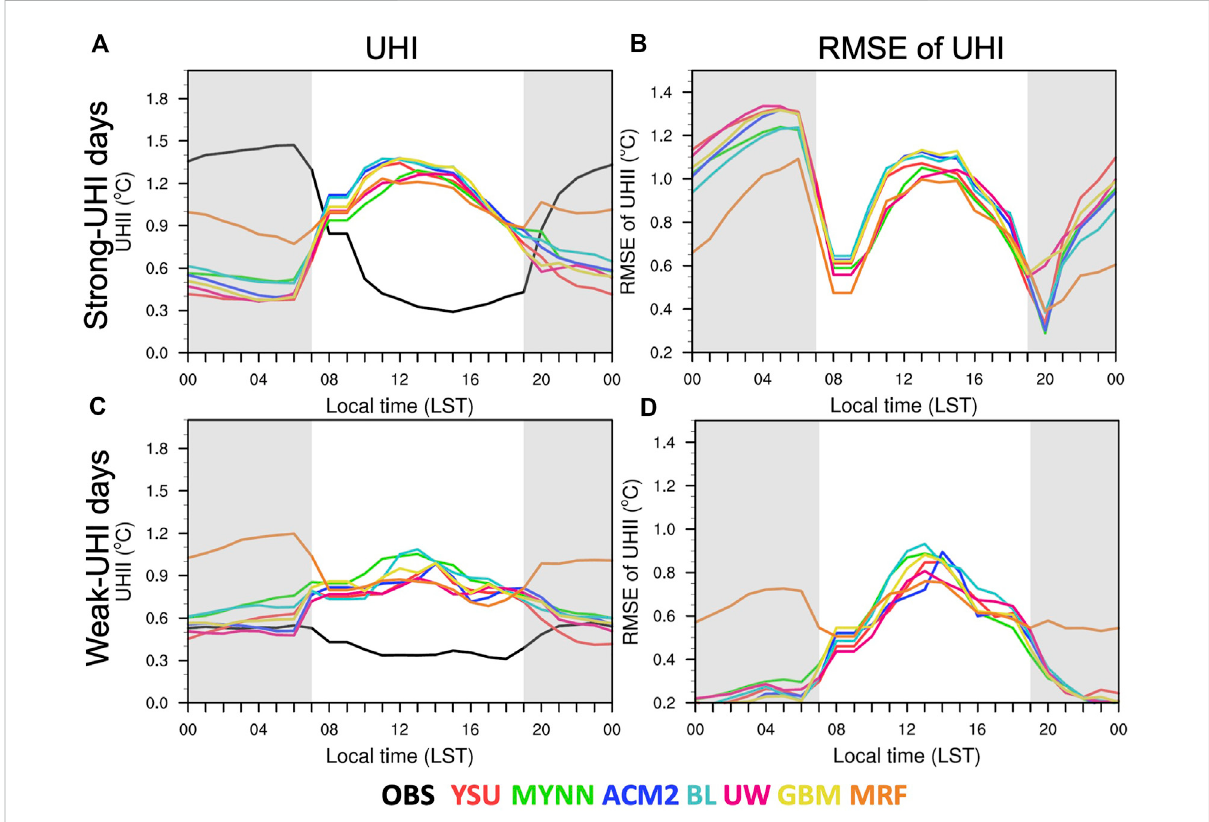
FIGURE 8 (A) Comparisons of the observed and simulated diurnal variations in the domain-averaged UHI on strong-UHI days and (B) the corresponding root mean square error of the model. (C,D) and are similar to (A,B) but on weak-UHI days. The gray zones denote the nocturnal time window from 1900 LST to 0700